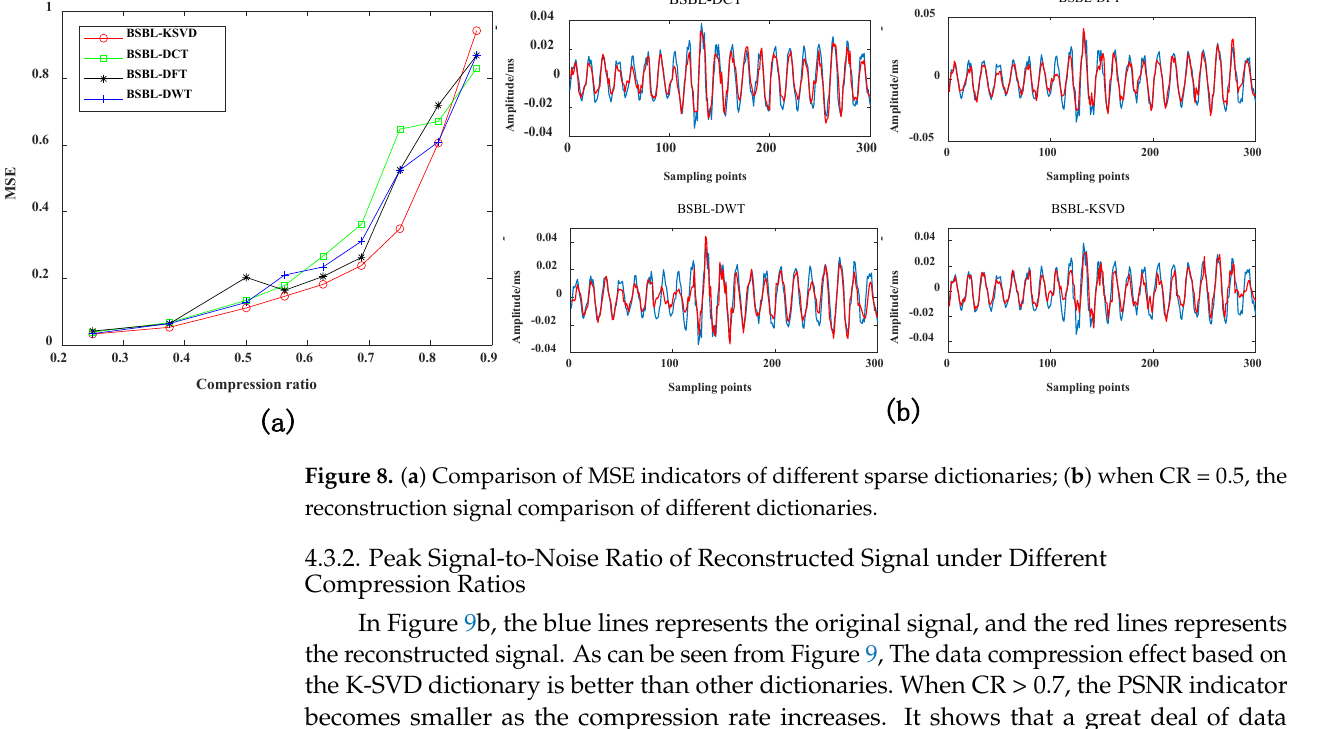
Figure 9. ( a ) Comparison of PSNR indicators for different sparse dictionaries; ( b ) when CR = 0.7, the reconstruction signal comparison of different dictionaries.